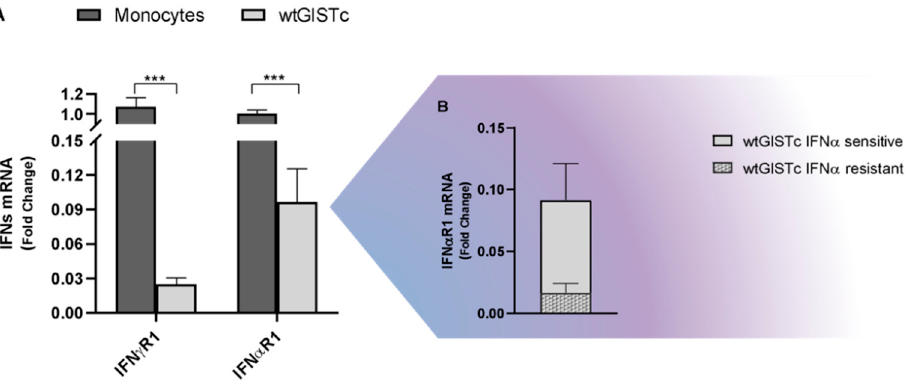
Figure 7. IFN α and IFN γ receptors (subunit 1) in wtGISTc. wtGISTc were confirmed to express IFN α / γ R1 even if at a lower level than monocytes, used as positive controls ( A ). The expression levels of IFN α R1 mRNA were significantly higher in wtGISTc sensitive to IFN α ( B ). All values are represented in fold change and normalized on three housekeeping genes (GAPDH, HPRT and PGK). (*** p < 0.001, nonparametric t -test).